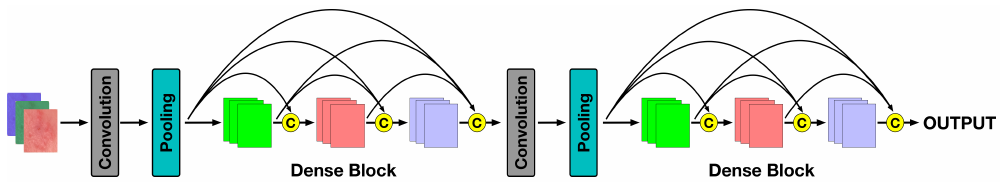
Figure 4. Block diagram of a deep DenseNet. The C within a yellow circle represents the concatenation operation.